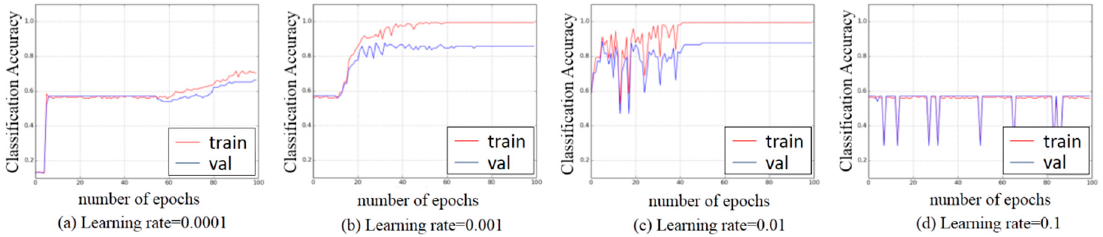
Figure 8. Comparison of classifier performance on different learning rates. ( a ) Learning rate=0.0001; ( b ) Learning rate=0.001; ( c ) Learning rate=0.01; ( d ) Learning rate=0.1.